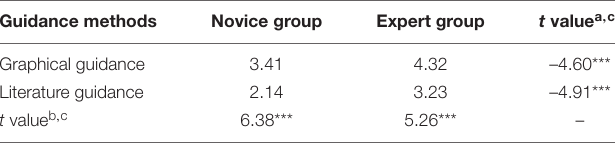
FIGURE 2 | Main effect of customer knowledge on WOM